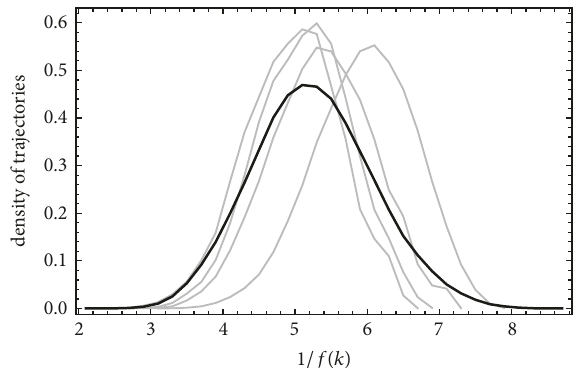
Figure 7: Trajectory density for the TSP . Probability density for trajectory length [ 1/𝑓(𝑘) ]. We consider 𝑁 = 10 and an ensemble average over 100 different realizations of the static problem (thick black curve). Several individual realizations are plotted as thick gray